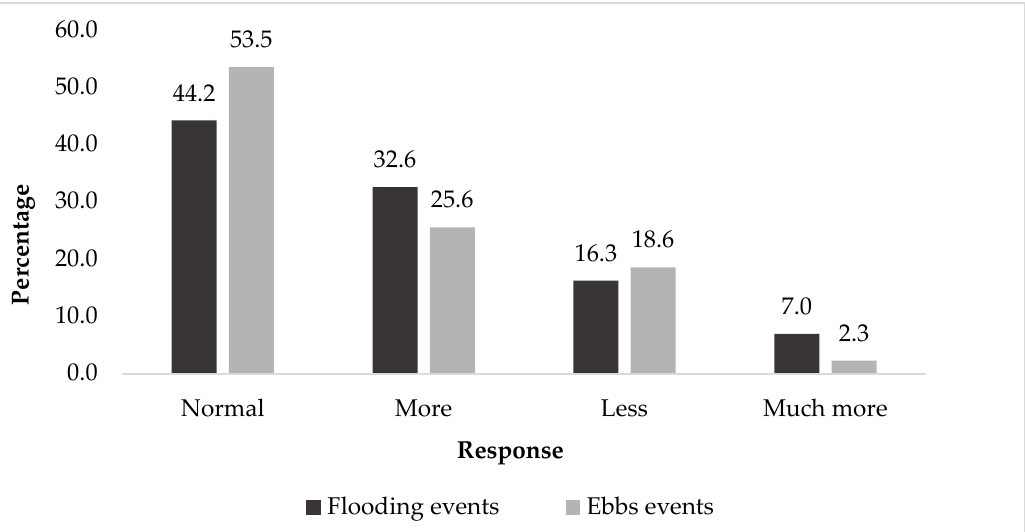
Figure 9 . Perception of extreme events in the Rio Negro.